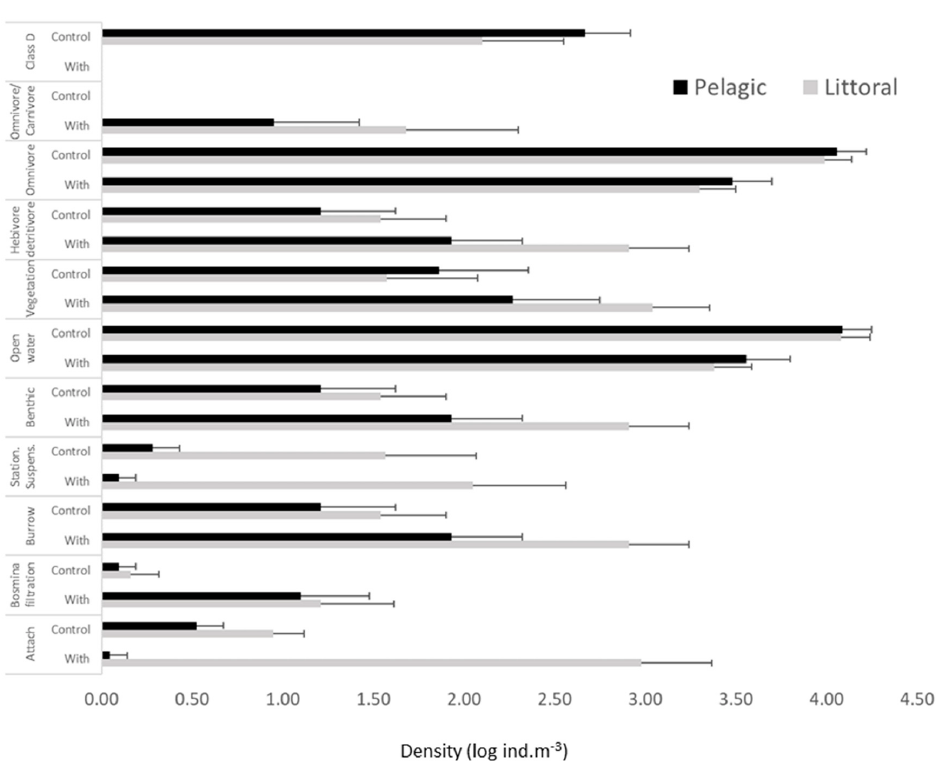
Figure 3. Mean logarithmic densities ( ± Standard Error (SE)) of functional traits in the littoral and pelagic habitats by macrophyte treatment. Table 3. Two-way ANOVA results comparing log density of each functional group by treatment (with macrophytes and control), by zones (littoral and pelagic), and for the interaction of treatment and zone. Trait abbreviations as in Table 1.